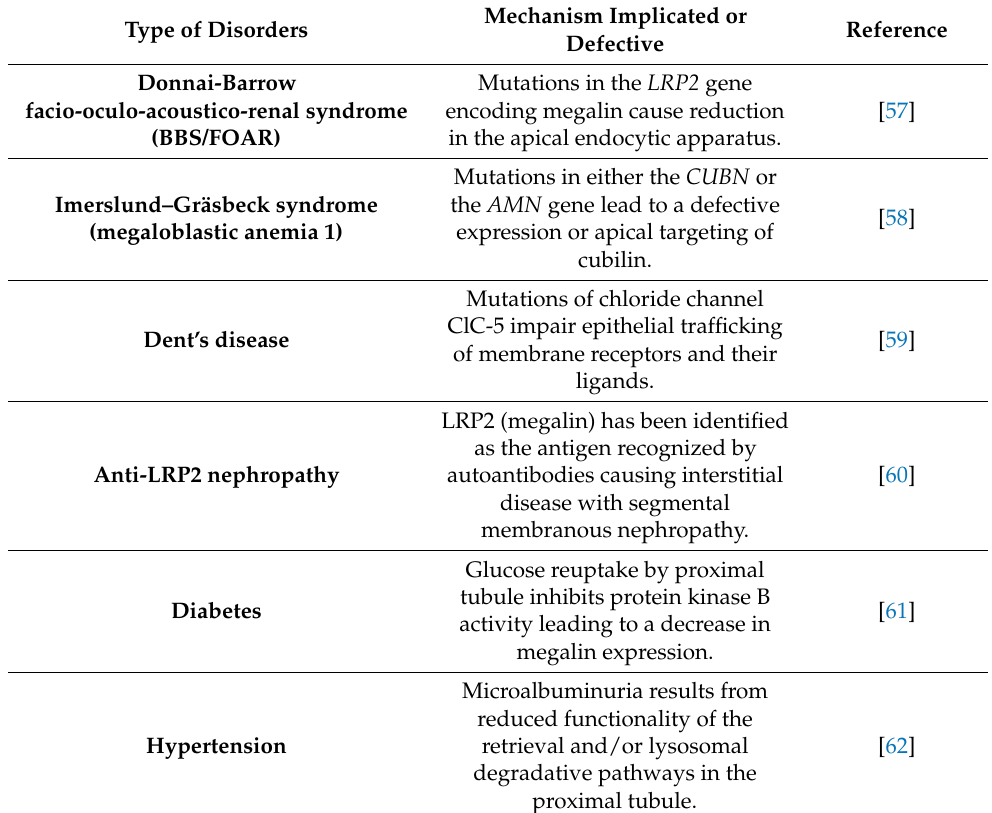
Table 1. Disorders associated with impaired renal handling of